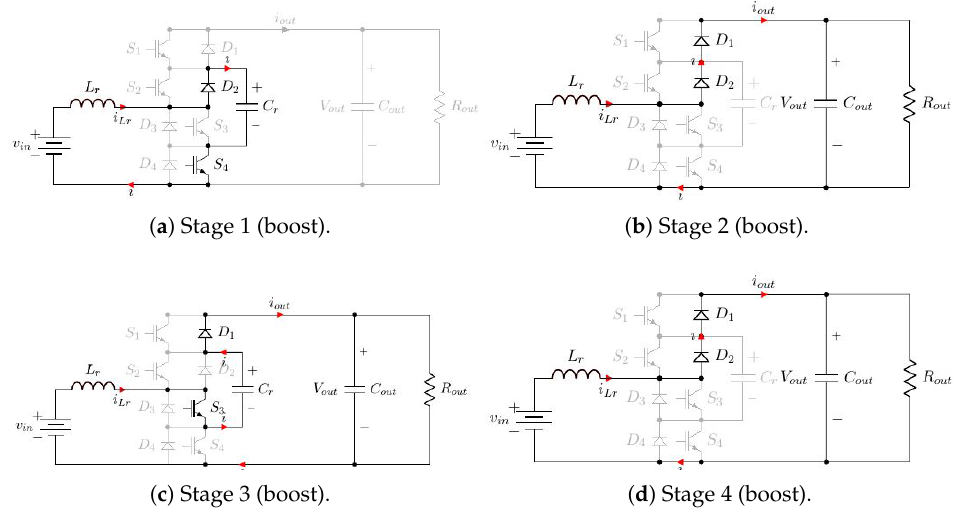
Figure 8. Representation of the topological